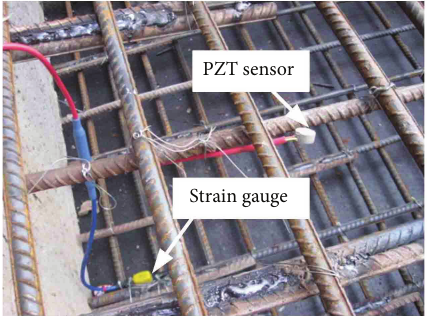
Figure 15: Protection of sensor.